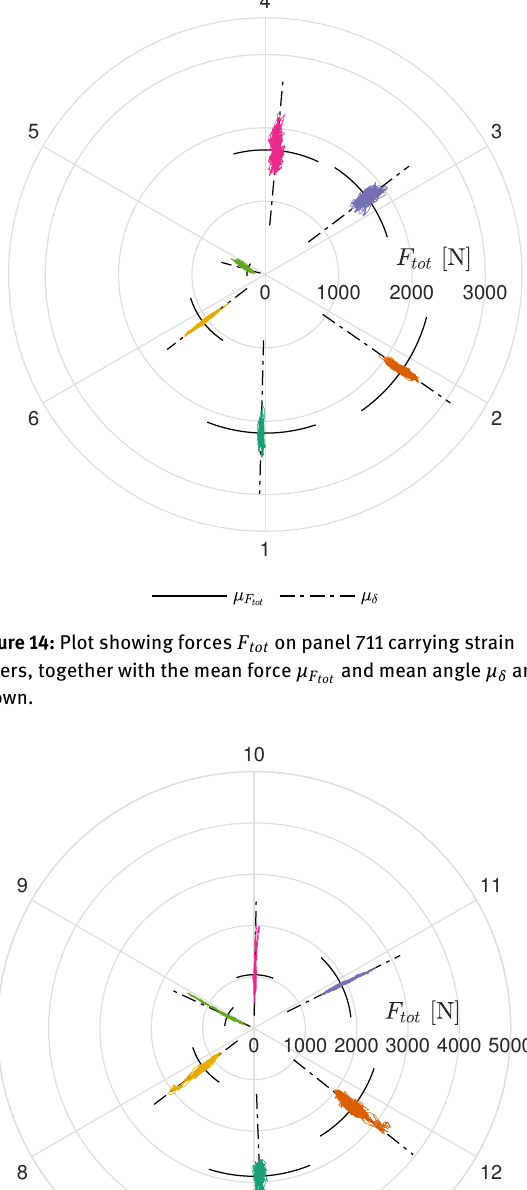
Figure 17: Left, right and summed force acting on roller 01 on panel 145 while conveying material. On the same axis the instantaneous material flow rate is plotted. The boundary indicates one complete belt